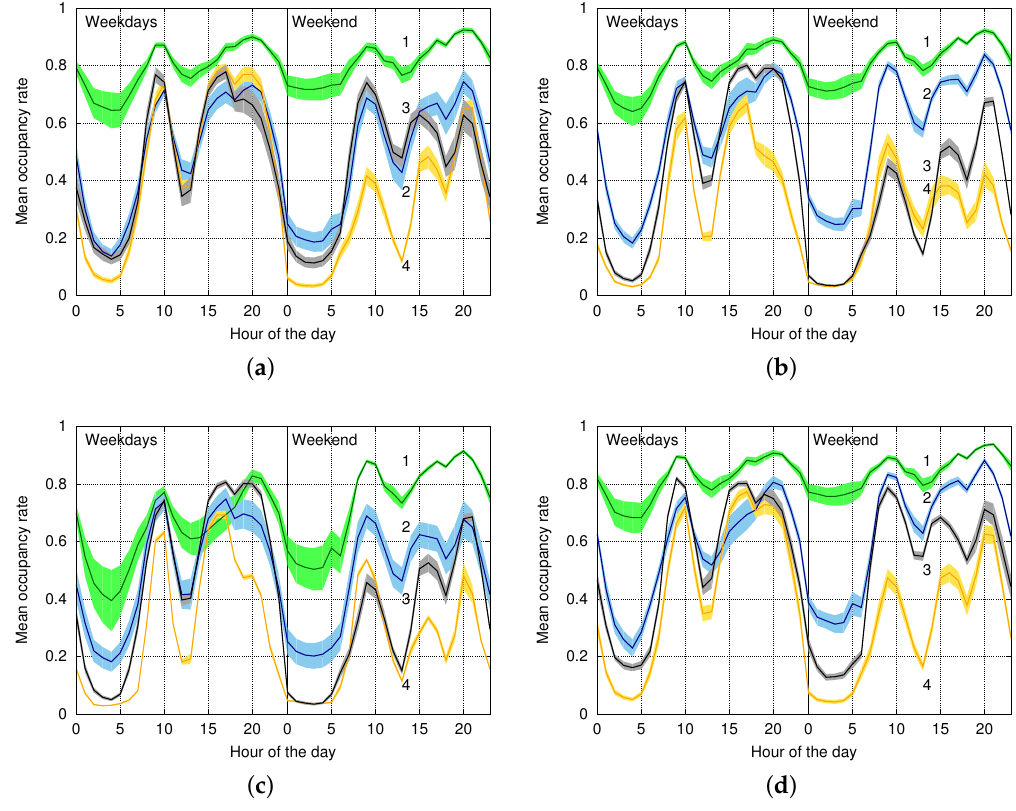
Figure 11. Clusters obtained on the Worldsensing dataset. ( a ) k -means; ( b ) EM; ( c ) DBSCAN; ( d ) SOM.